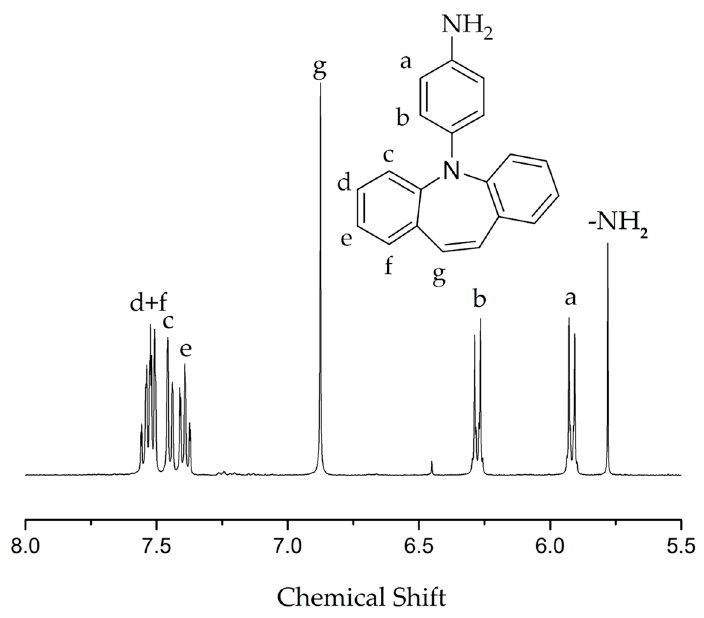
Figure A1. 1 H NMR spectrum of M1 in DMSO- d 6 .